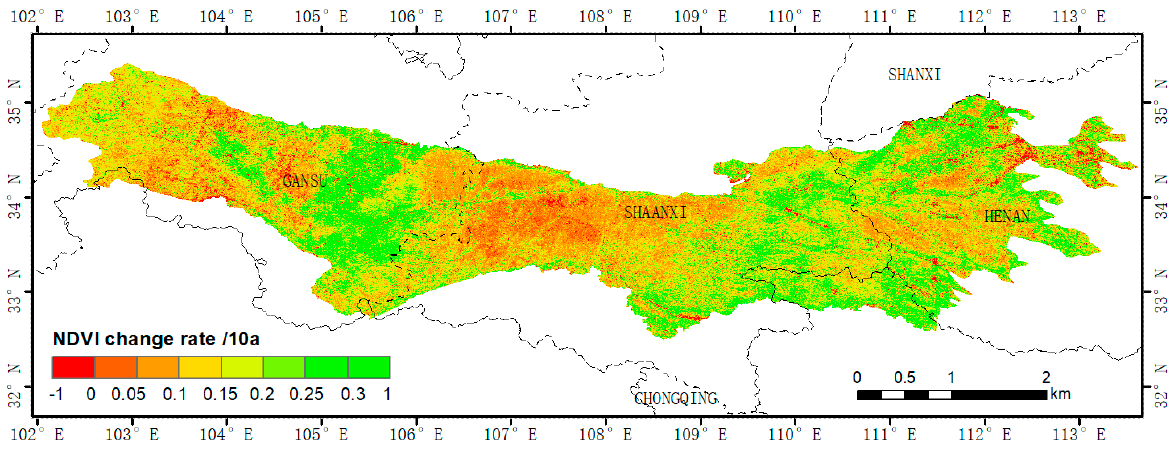
Figure 5. NDVI Change rate in Qinling Mountains during 1987–2018.